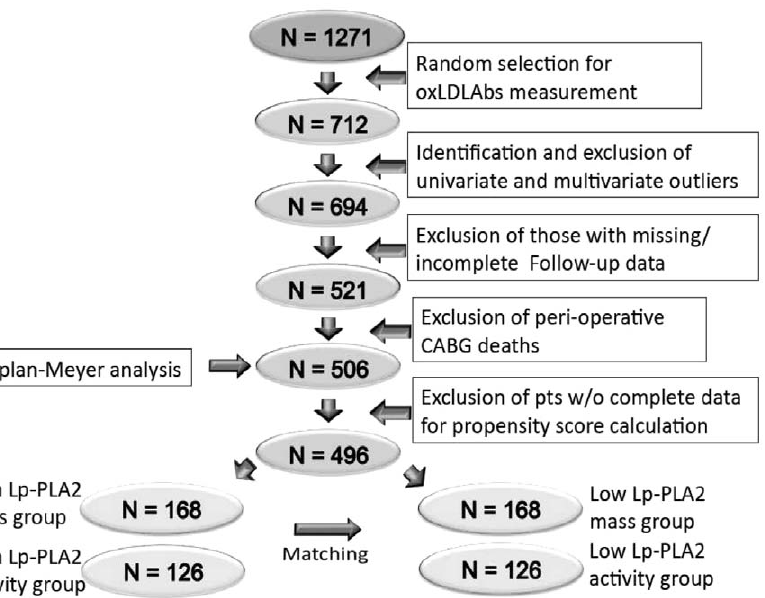
Figure 1. Data analysis flow chart. The flow chart shows the selection process by which the patients were submitted to statistical analysis.